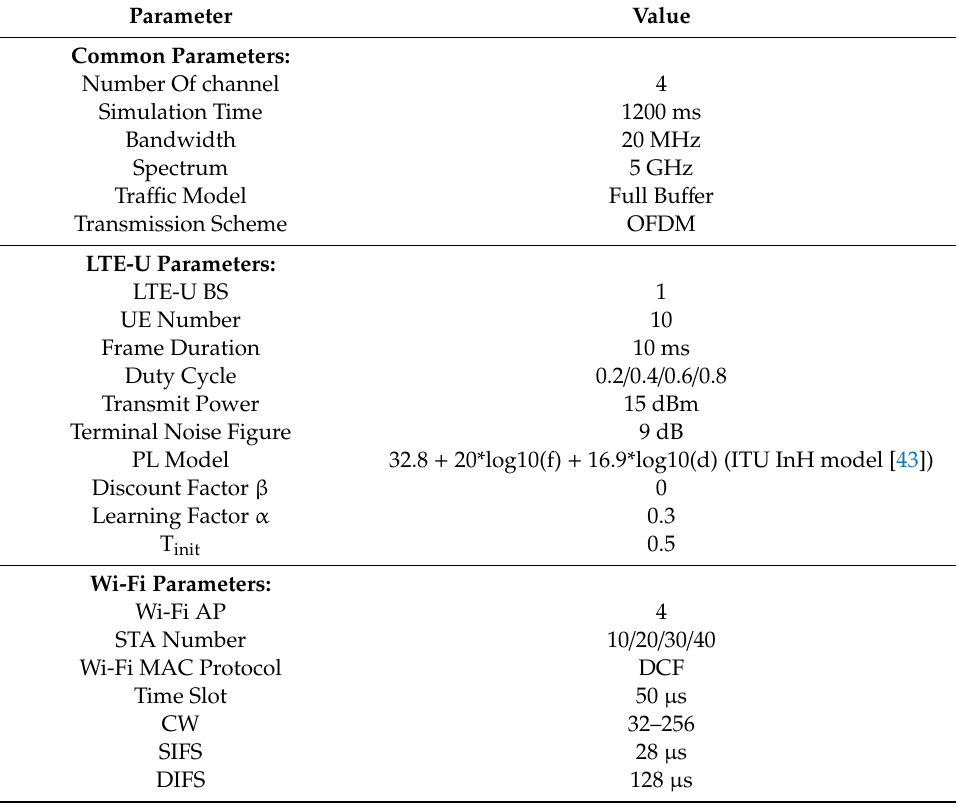
Table 1. Simulation